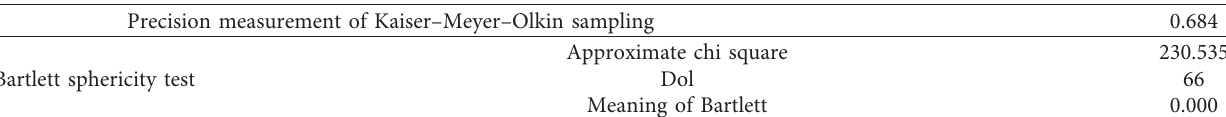
Table 5: KMO index and Bartlett test.